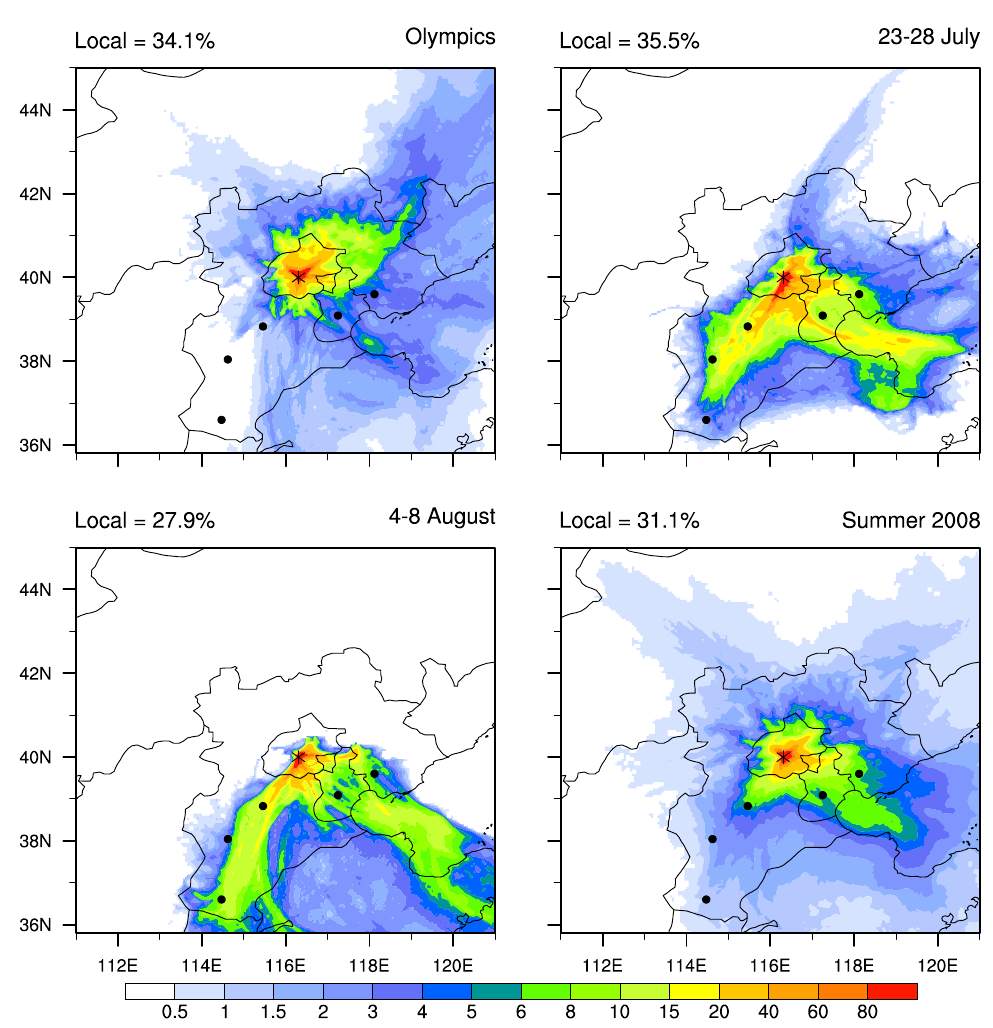
Fig. 13. Averaged footprints (residence times of 48-h backward trajectories) for four periods: the Olympics, two pollution episodes (23–28 July, 4–8 August), and the whole summer (June, July, August) of 2008. The black dots represent the loci of major cities in the North China Plain, as shown in Fig. 1. The PKU site is marked by an